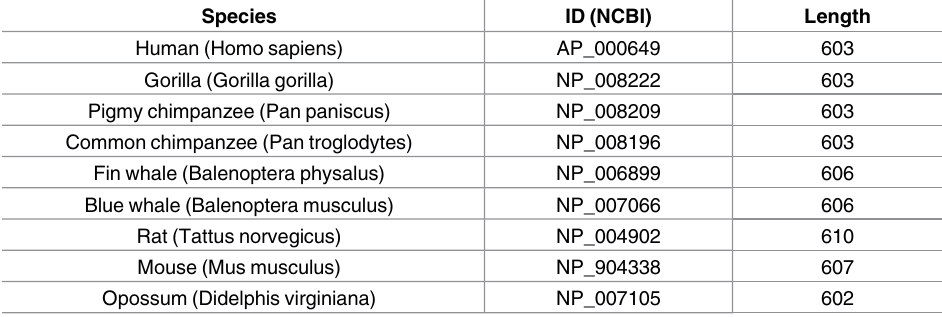
Table 1. Information of ND5 for nine